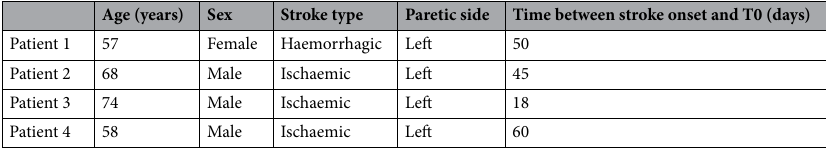
Table 1. Demographic and clinical characteristics of